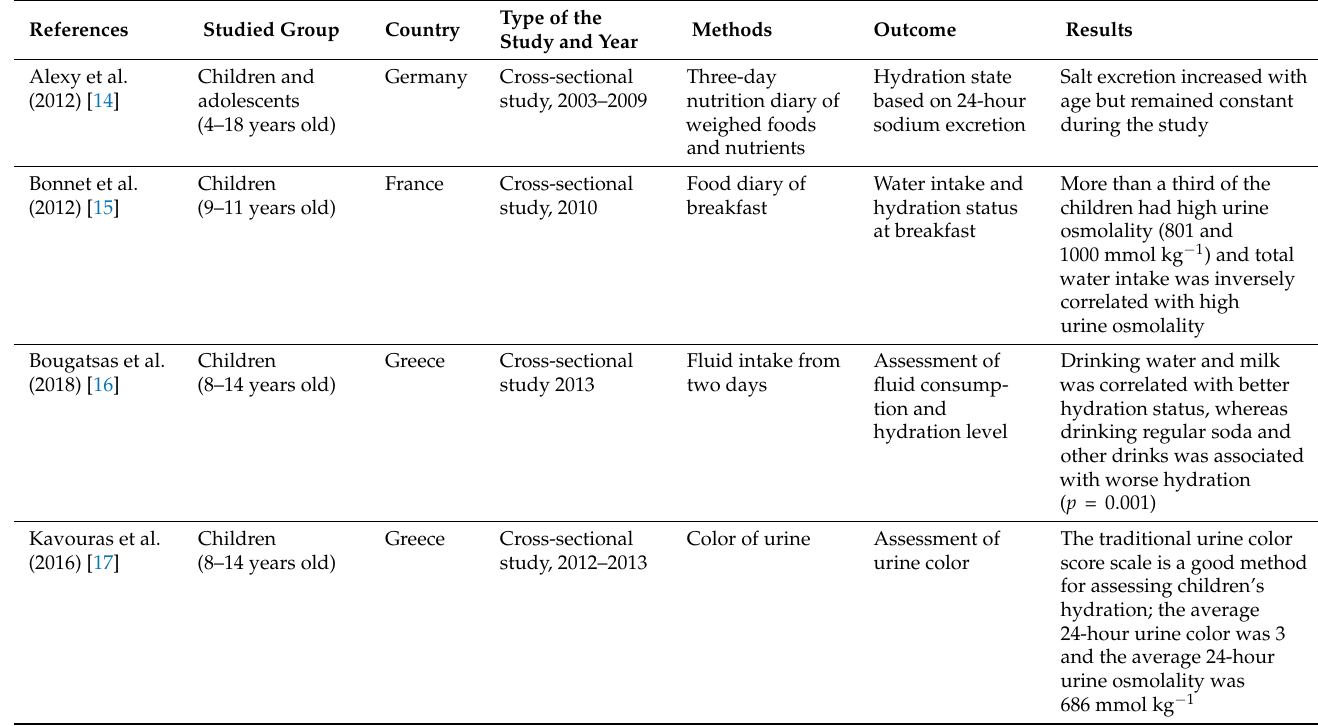
Table 1. Cross-sectional, longitudinal, and intervention studies including hydration status measure- ment in